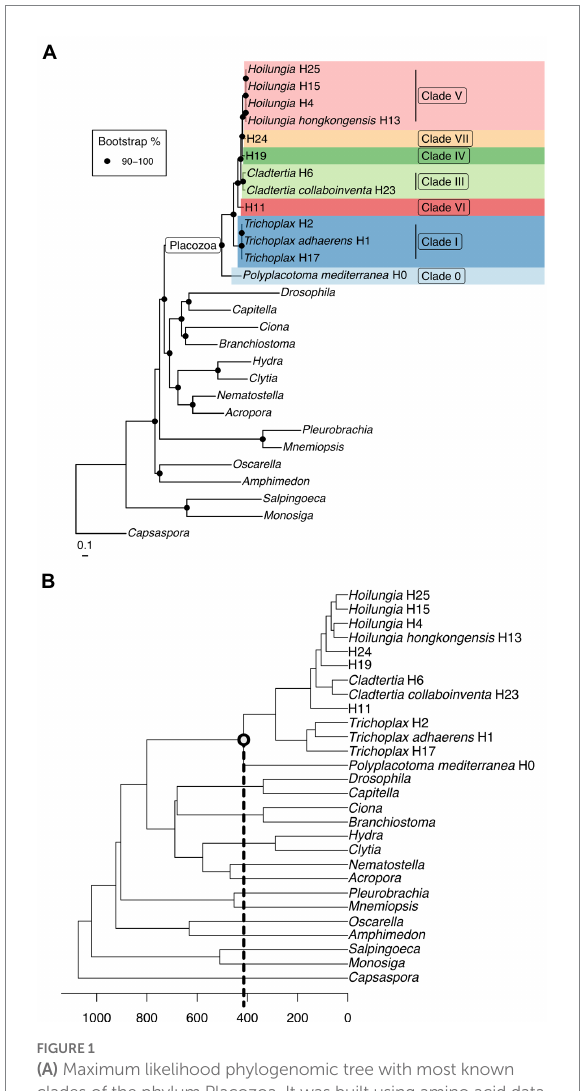
FIGURE 1 (A) Maximum likelihood phylogenomic tree with most known clades of the phylum Placozoa. It was built using amino acid data from 2,309,771 characters spread across 1,882 orthologs (only those found in ~90% of taxa), plus 51 morphological characters with 50X weighting. Clade nomenclature follows prior research (Eitel et al., 2013), with the addition of Clade 0. This does not include our updated nomenclature for higher taxonomy, but does give our narrower definition of Hoilungia . (B) Chronogram of the maximum likelihood phylogenomic topology (calibration points are based on TimeTree). Please note that the focal node (and all other internal Placozoa nodes) are not fossil calibrated, and accordingly can only be considered a very rough